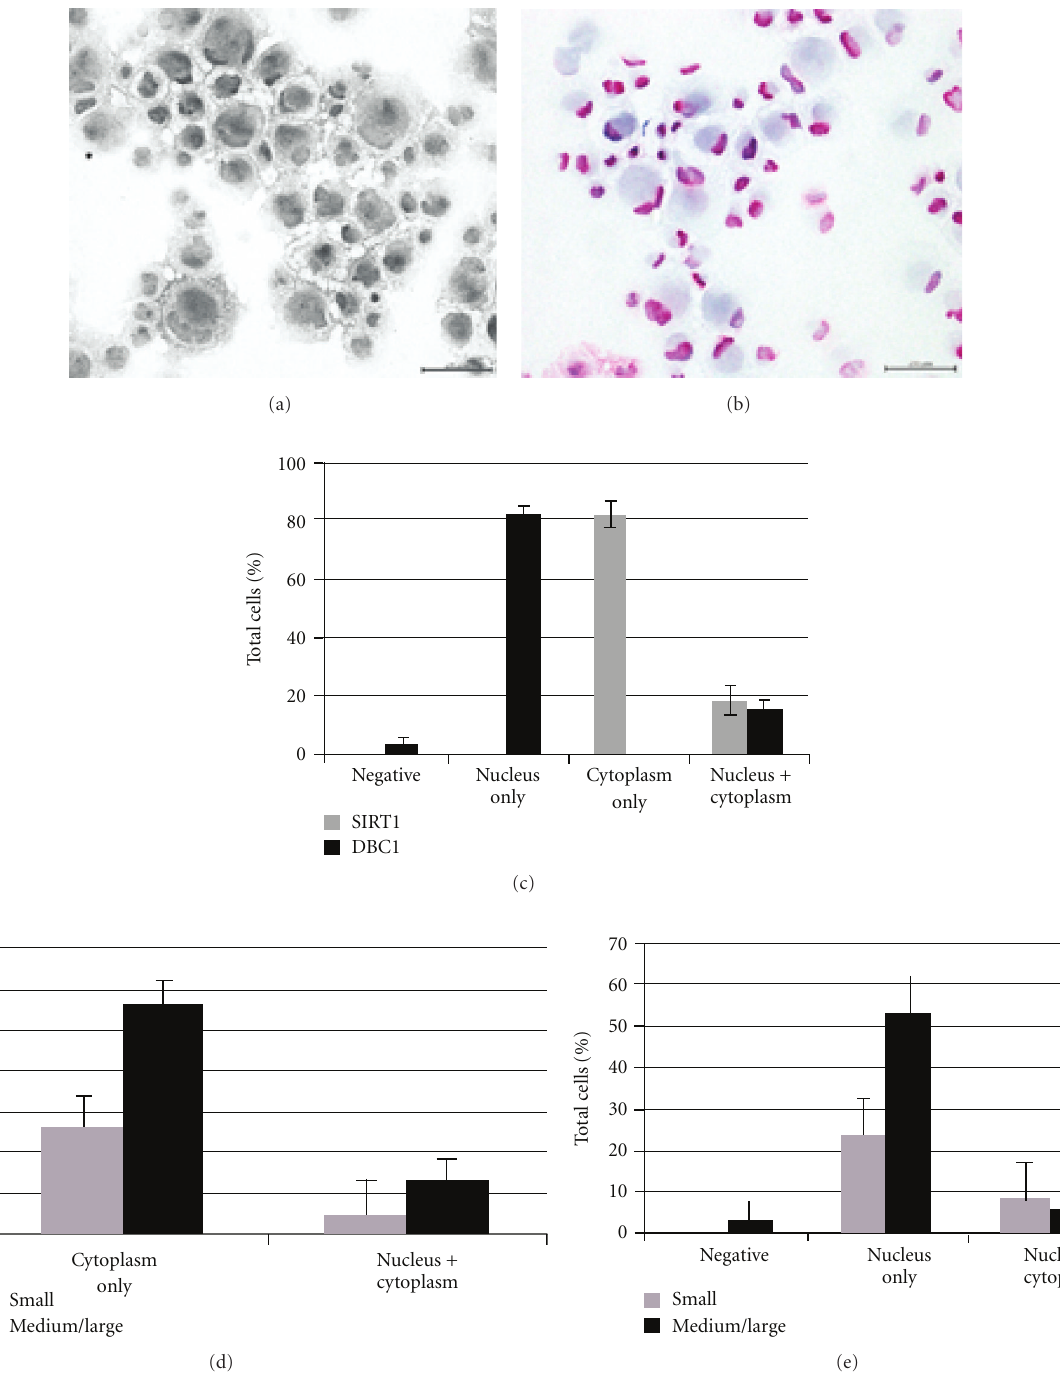
Figure 4: (a) Light microscope image of hRPCs immunostained for SIRT1. Immunoreactivity can be seen predominantly in the cytoplasm but also in the nuclei of some cells. (b) hRPCs immunostained for DBC1. Immunoreactivity can be seen predominantly in the nuclei but also in the cytoplasm of some cells. (c) Distribution of SIRT1 and DBC1 staining in hRPCs. (d) SIRT1 staining classification and hRPC cell size. Of note, SIRT1 positivity was observed in both the cytoplasm and nucleus in hRPCs of all sizes. No significant di ff erence in SIRT1 distribution was observed for small versus medium/large cells. (e) DBC1 staining classification and hRPC cell size. Of note, DBC1 positivity in the cytoplasm was more frequently seen in small cells compared to medium/large cells. Also, some medium/large cells were negative for DBC1 whereas all small cells were DBC1